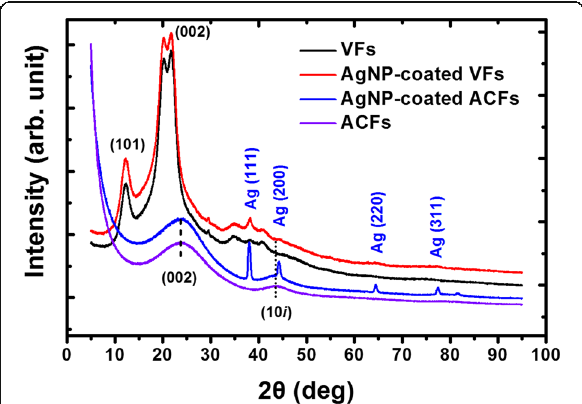
Fig. 6 XRD patterns of (black) pure CFs, (red) AgNP-coated CFs, (blue) Ag nanohair-grown ACFs, and (purple) pure